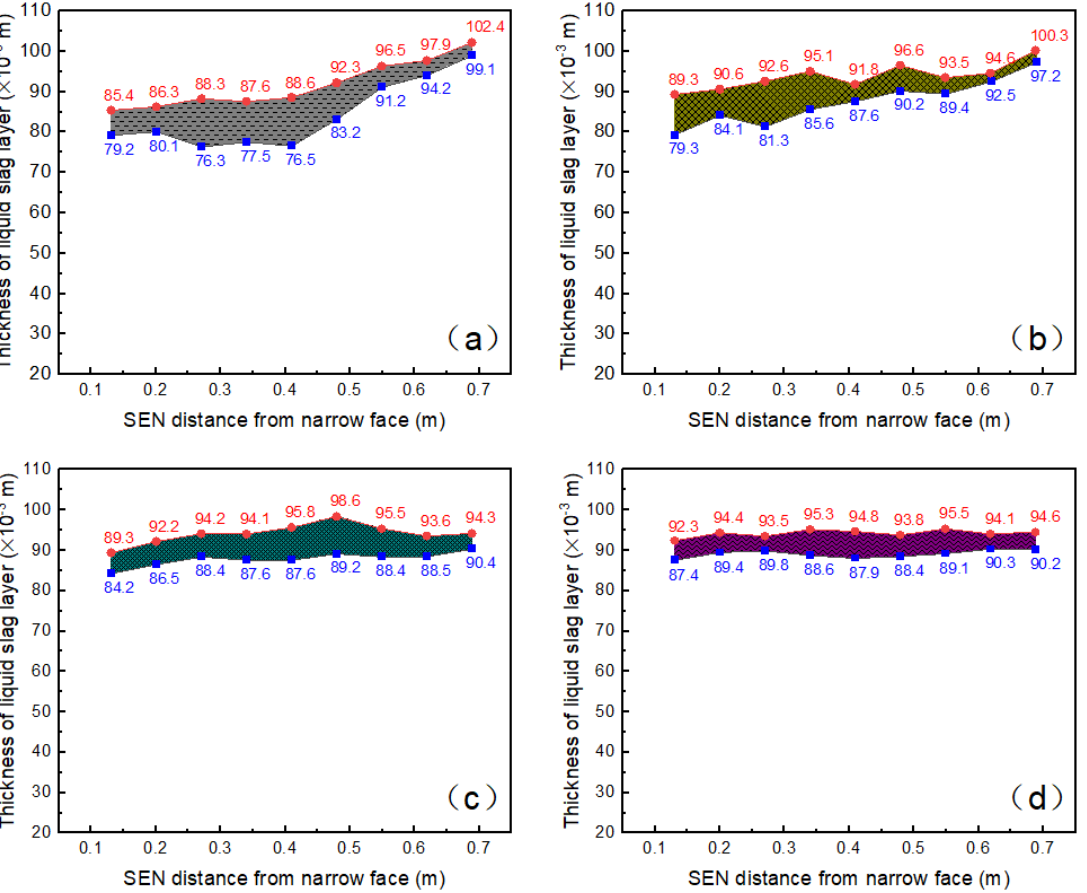
Figure 22. The thickness of the liquid-slag layer. ( a ) No EMBr, ( b ) 300-200, ( c ) 800-600 and ( d ) 1100-800